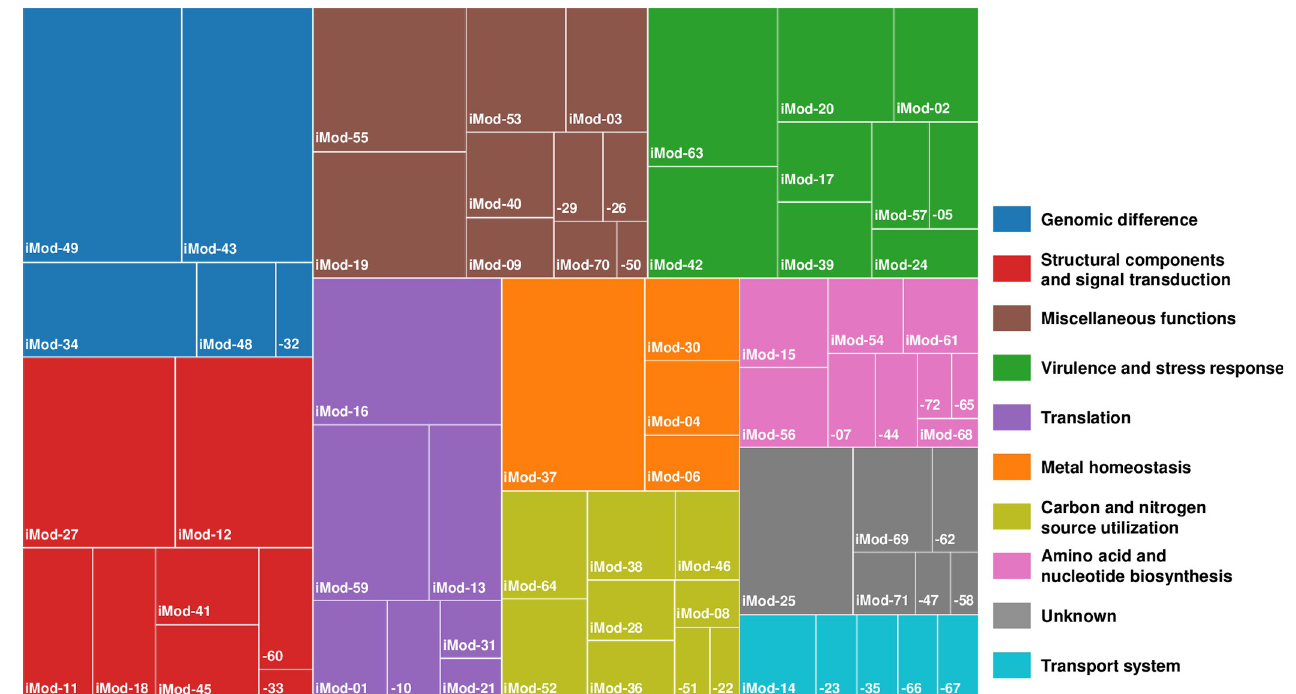
Fig 2. Categorization of the iModulons by their biological functions. 72 iModulons identified by ICA were grouped into 10 categories according to their biological functions as illustrated with different colors. The number of genes in each iModulon is indicated by the size of the box.